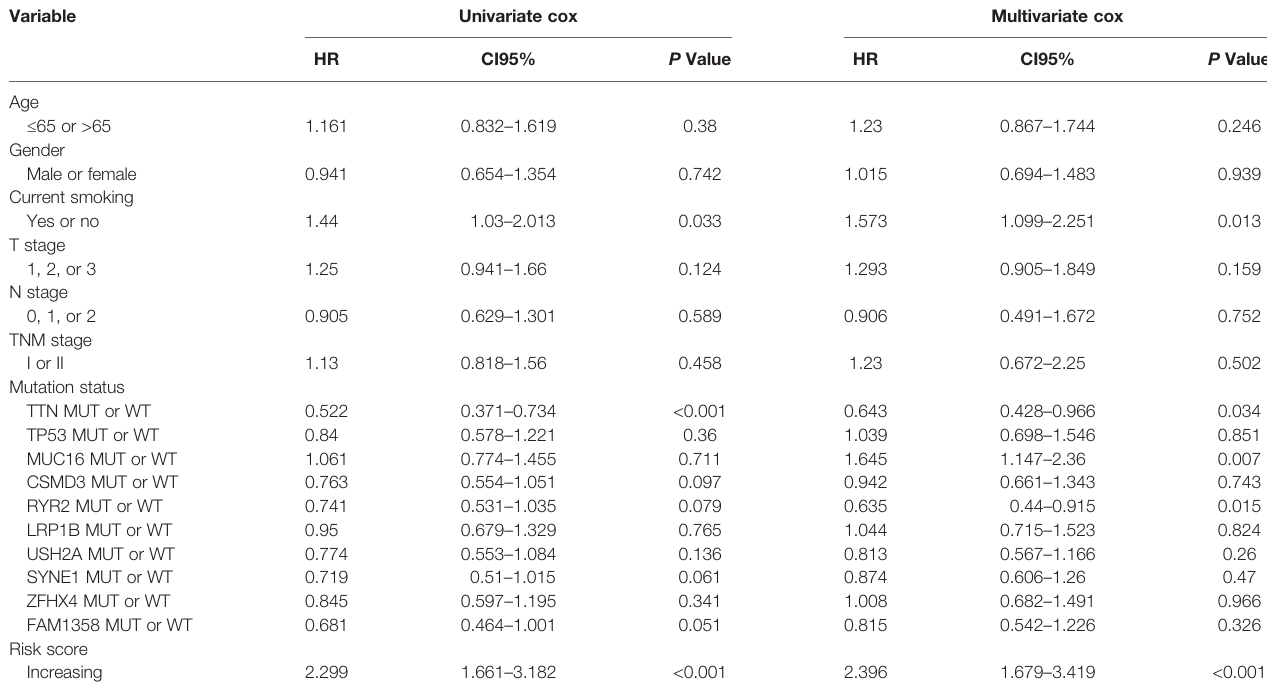
TABLE 2 | Univariable and multivariable Cox regression analyses of characteristics with overall survival in TCGA cohort.